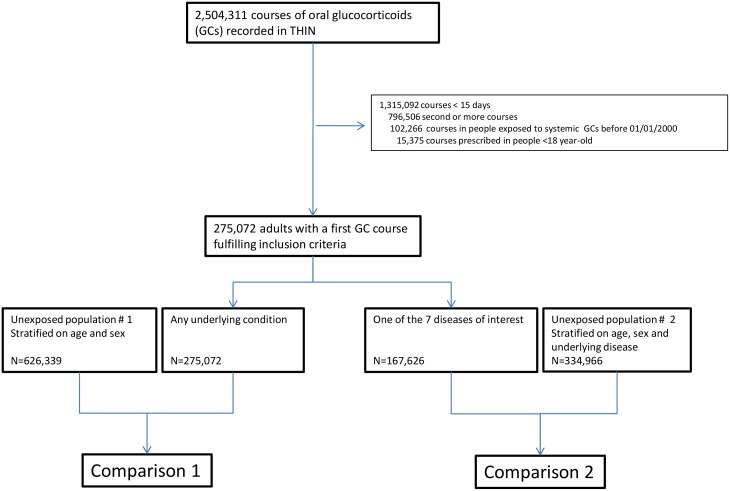
Study flowchart.